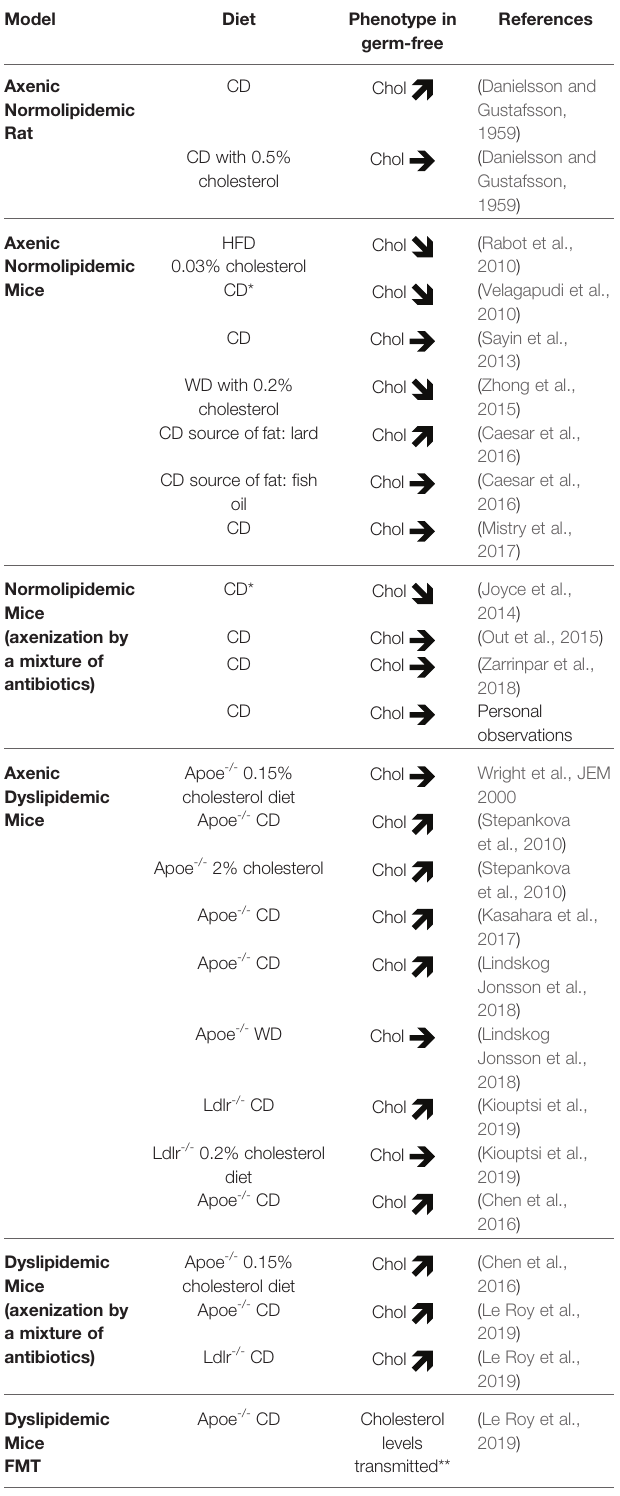
TABLE 2 | List of major pre-clinical